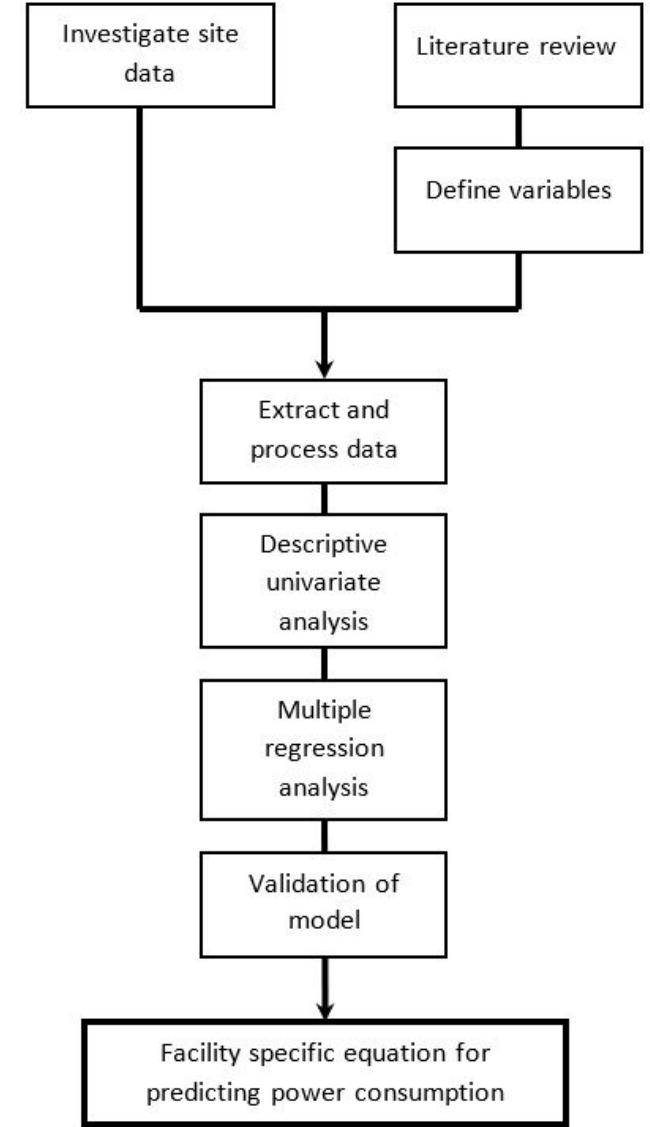
Figure 2. Block diagram representing the workflow of the